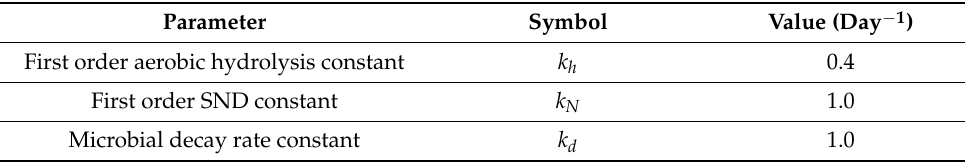
Table 1. Biological parameter for